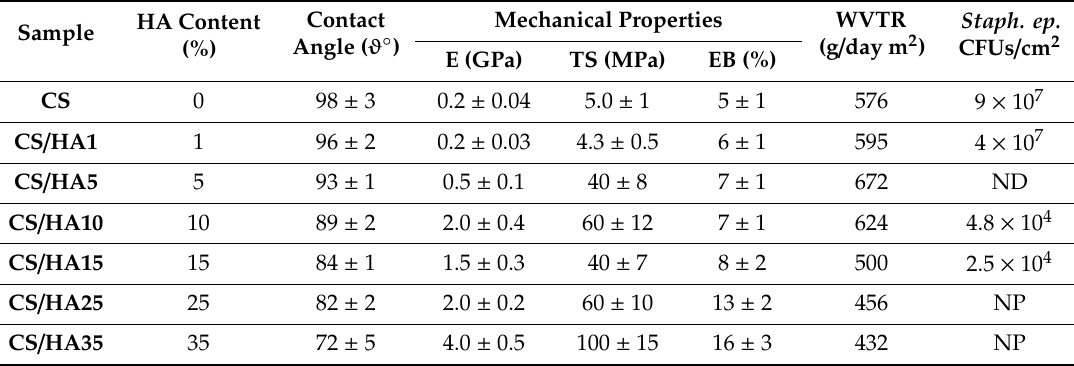
Table 1. Acronyms and properties of CS / HA matrices. E = Young modulus; TS = Tensile strength; EB CFU/cm 2 ); NP = Not Performed (because of film dissolution in the adopted experimental conditions).